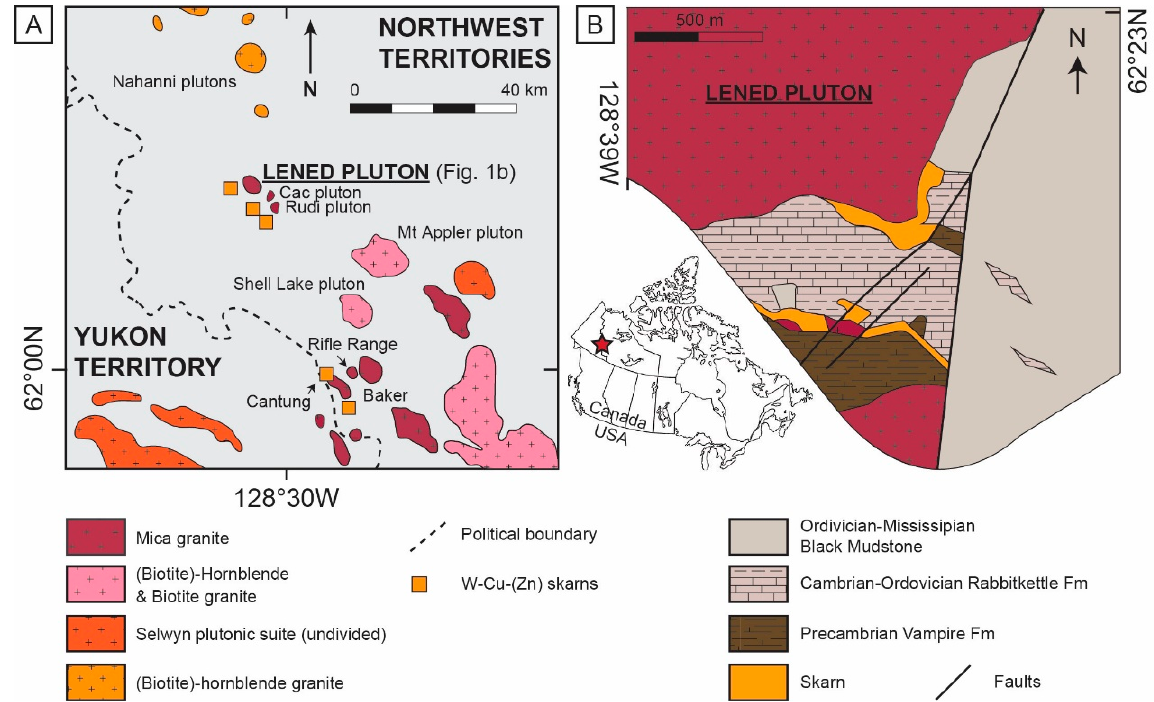
Figure 1. ( A ) Simplified regional map showing the location of granitic plutons and skarns within the Tungsten belt (modified after [35]), and ( B ) local map of the Lened W-(Be) deposit (modified after [26]), representing the whole sampling area for this study.